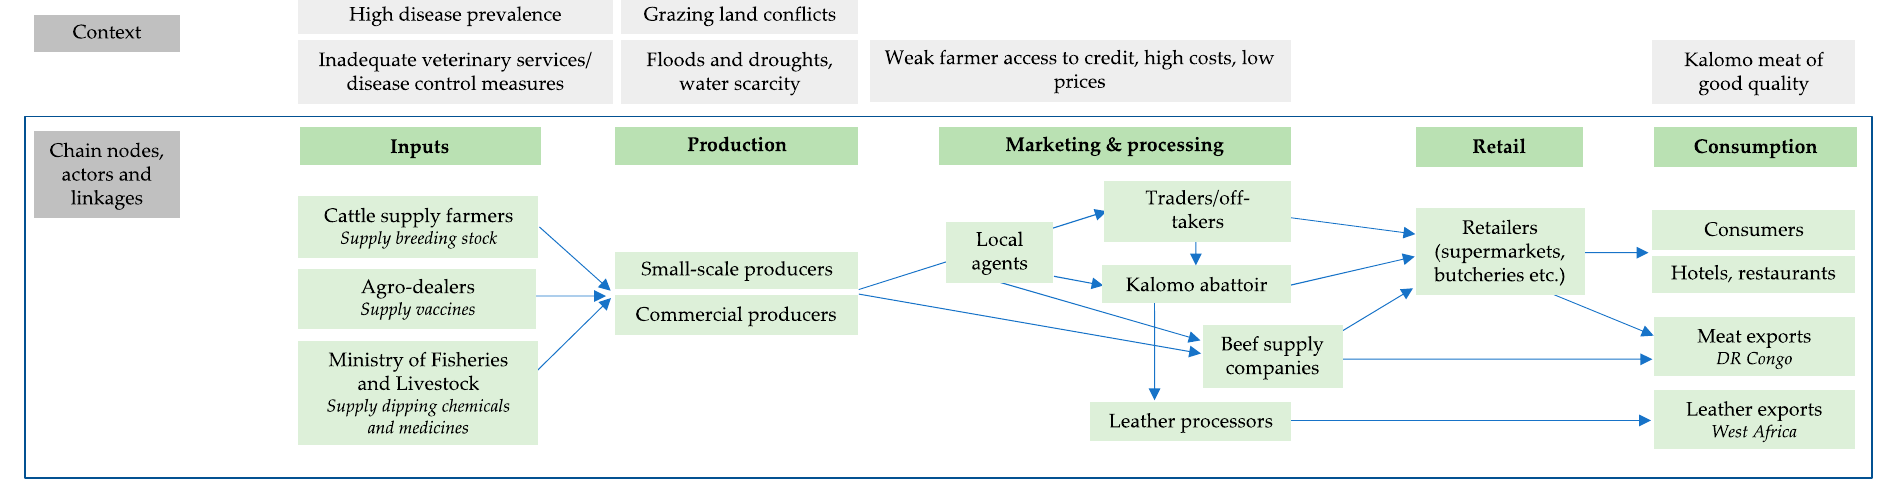
Figure 5. Cattle value chain and context in Kalomo District (Source: Authors’ construct based on field research data).